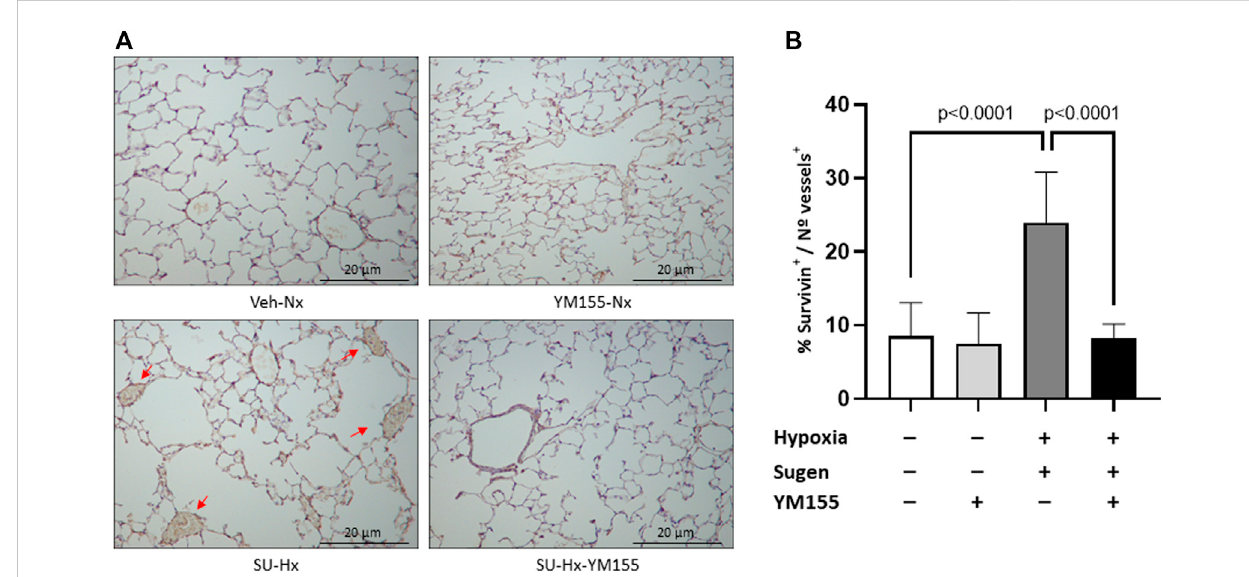
FIGURE 4 Effect of YM155 on survivin protein expression in small pulmonary arteries in SU5416/hypoxia-induced PAH mice. (A) Photomicrographs showing the immunostaining for survivin in small pulmonary vessels in the different experimental groups (Veh-Nx = vehicle and normoxia; YM155-Nx = vehicle, normoxiaandYM155;SU-Hx=SU5416andhypoxia;SU-Hx-YM155=SU5416,hypoxiaandYM155). (B) Percentofsurvivinpositivevesselswithrespectto the total number of vessels in each experimental group. Values are expressed as mean ± SD. Statistical signi fi cance was assessed by the one-way ANOVA. Arrows indicate the localization of survivin in small pulmonary